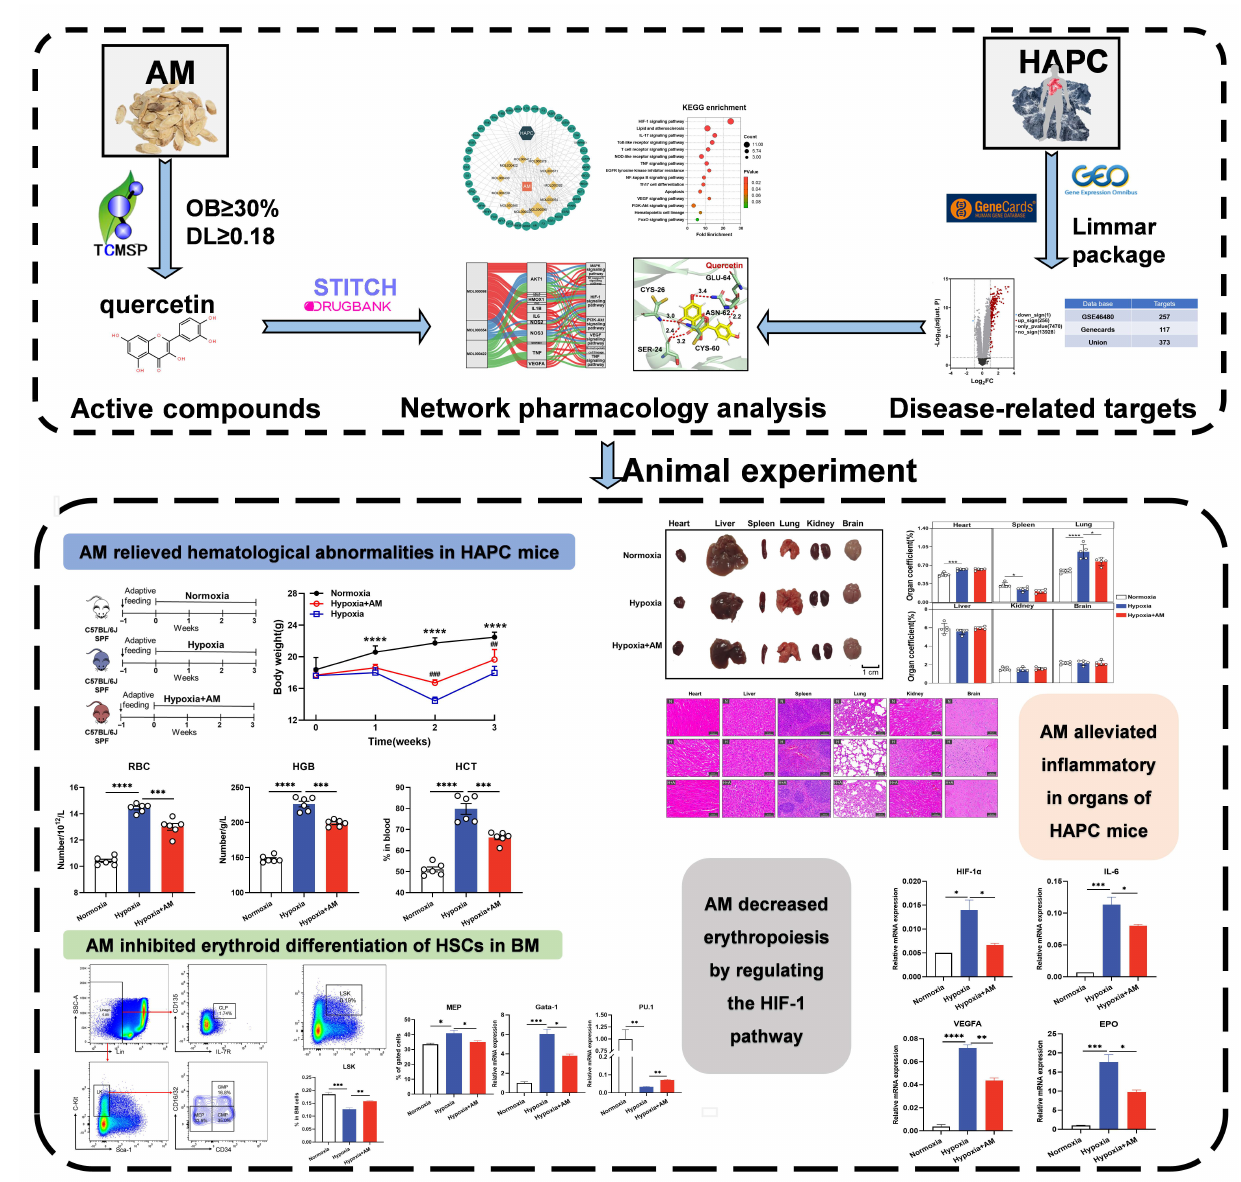
Figure 1. The workflow of this research. * p < 0.05, ** p < 0.01, *** p < 0.001, **** p < 0.0001; Normoxia vs. Hypoxia. ## p < 0.01, ### p < 0.001; Hypoxia + AM vs. Hypoxia.